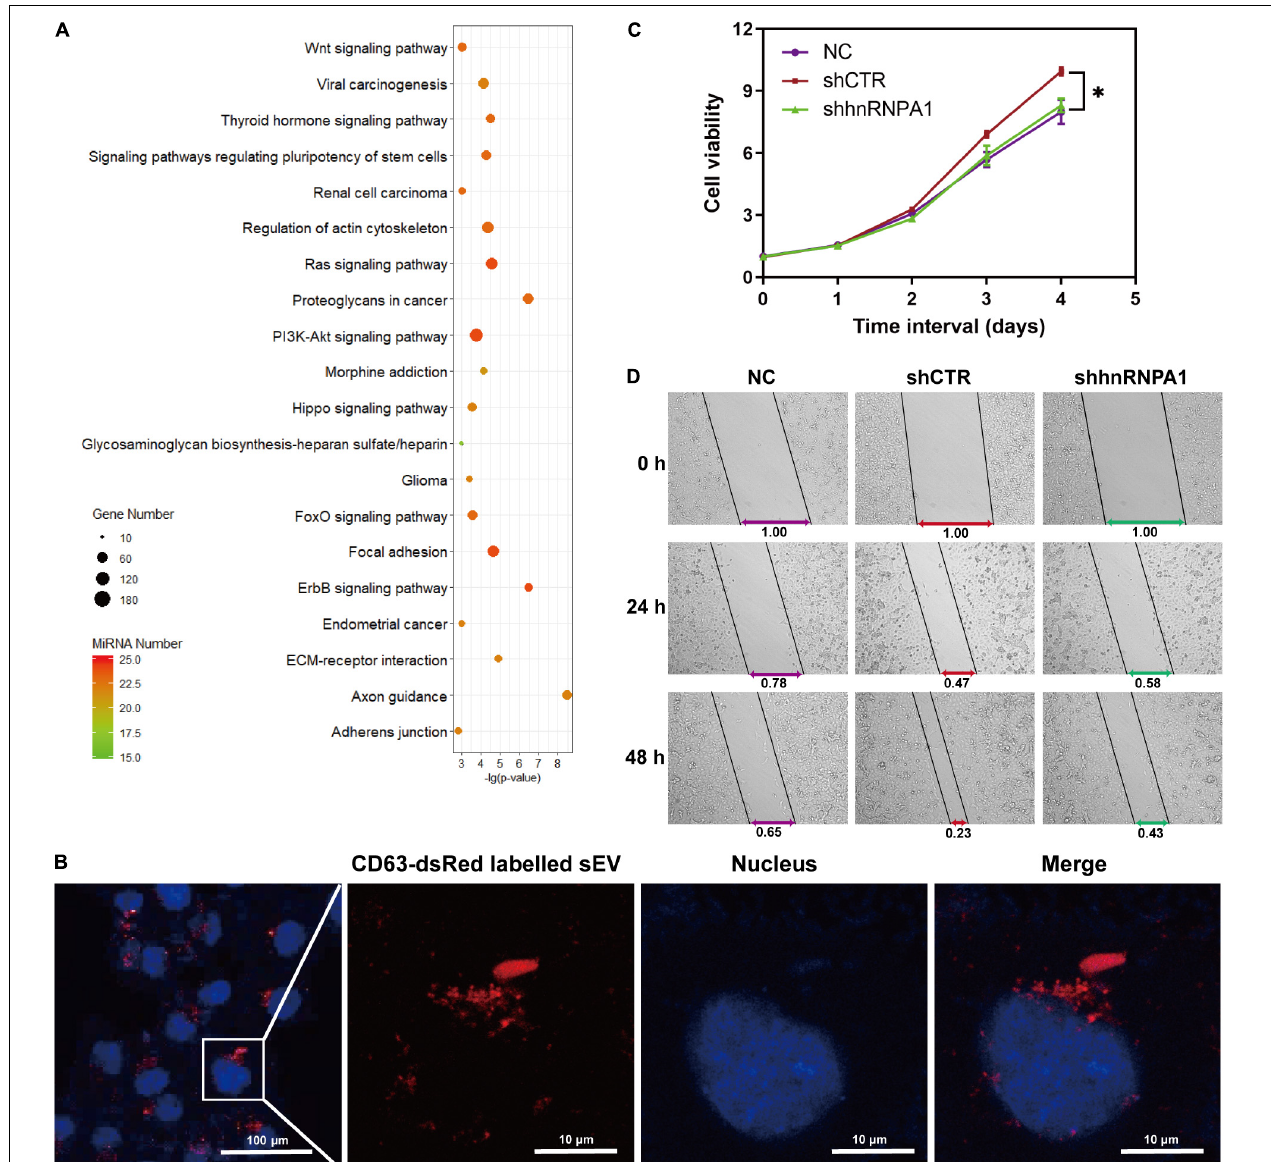
FIGURE 6 | sEV-miRNAs loaded by hnRNPA1 facilitate tumor proliferation and migration. (A) Bubble chart showing the 19 downregulated sEV-miRNA-associated KEGG pathways. DIANA TOOLS-mirPath v.3 was used, and 20 of the most associated pathways are shown. (B) Confocal microscope images showing CD63-dsRed-labeled sEVs uptaken by A549 cells (sEVs, red; and nucleus, blue). (C) Cell viability of A549 (* p < 0.05, error bars represent SEM). (D) Wound-healing assay of A549 cells treated with different sEVs. NC, A549 cells without exogenous sEVs; shCTR, A549 cells adding sEVs derived from shCTR cells; shhnRNPA1, A549 cells adding sEVs derived from shhnRNPA1 cells. sEV-miRNA, microRNA in small extracellular vesicle; hnRNPA1, heterogeneous nuclear ribonucleoprotein A1; KEGG, Kyoto Encyclopedia of Genes and